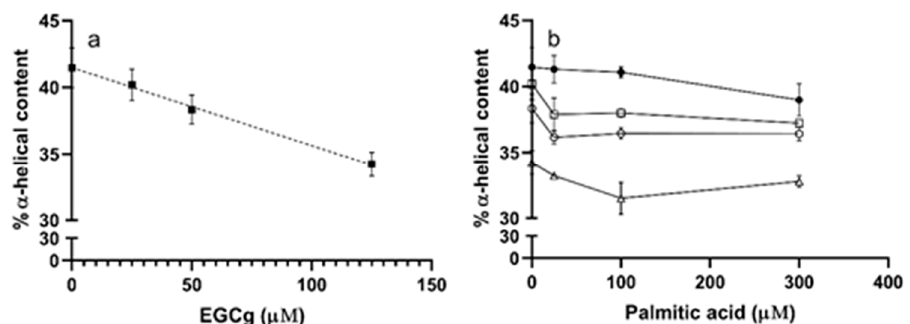
Figure 6. α -helical content in HSA (5 μ M) with 0–125 μ M of EGCg and/or 0–300 μ M PA. Each point was calculated from three replicates with SEM for error bars. ( a ) HSA (5 μ M) α -helical content with different concentrations of EGCg (0–125 μ M). The line was linearly fit (Prism) to yield slope—0.29 and r 2 = 0.72. ( b ) HSA (5 μ M) α -helical content in the presence of PA (0, 25, 100, 300 μ M) and EGCg (0, 25, 50, 125 μ M). ● , 0 μ M EGCg; □ , 25 μ M EGCg; о , 50 μ M EGCg; ∆ ,125 μ M EGCg.